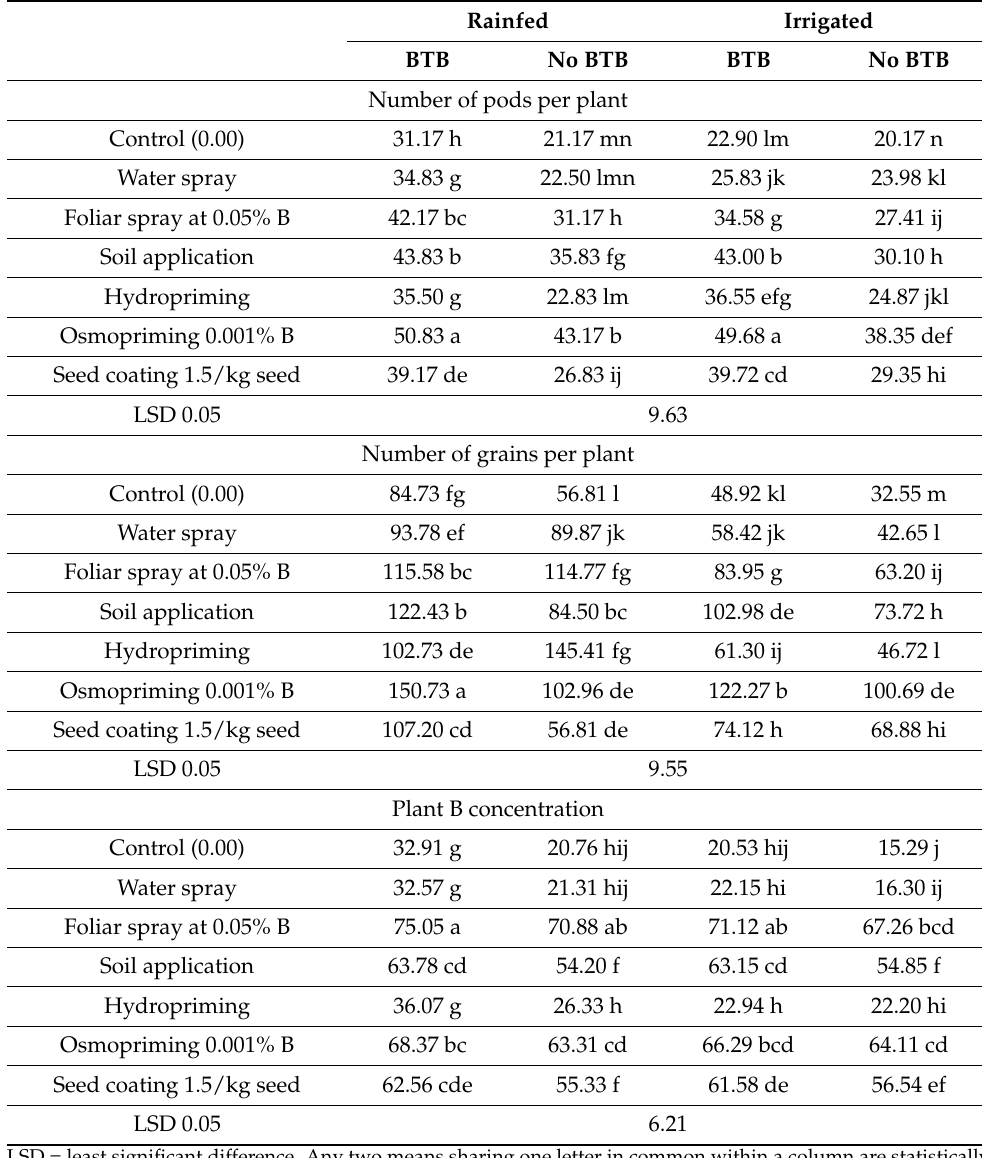
Table 7. The impact of location × BTB inoculation × boron application methods’ interaction on number of pods and grains per plant and plant boron concentration of desi